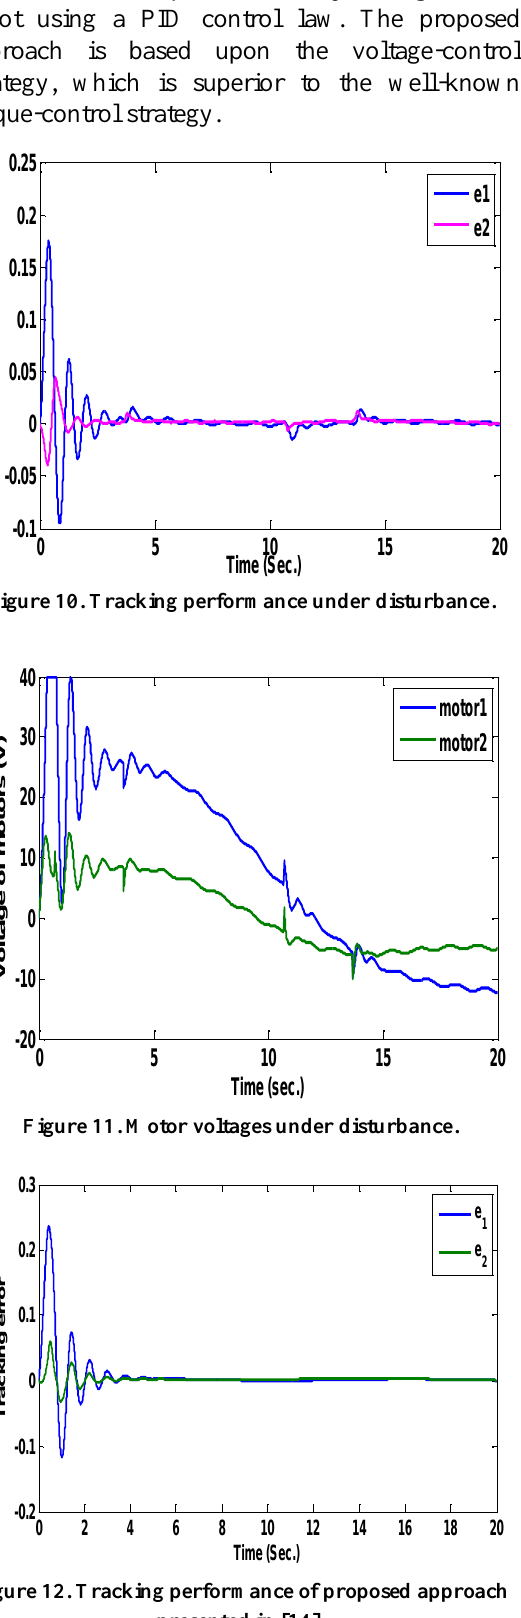
Figure 12. Tracking performance of proposed approach presented in [14]